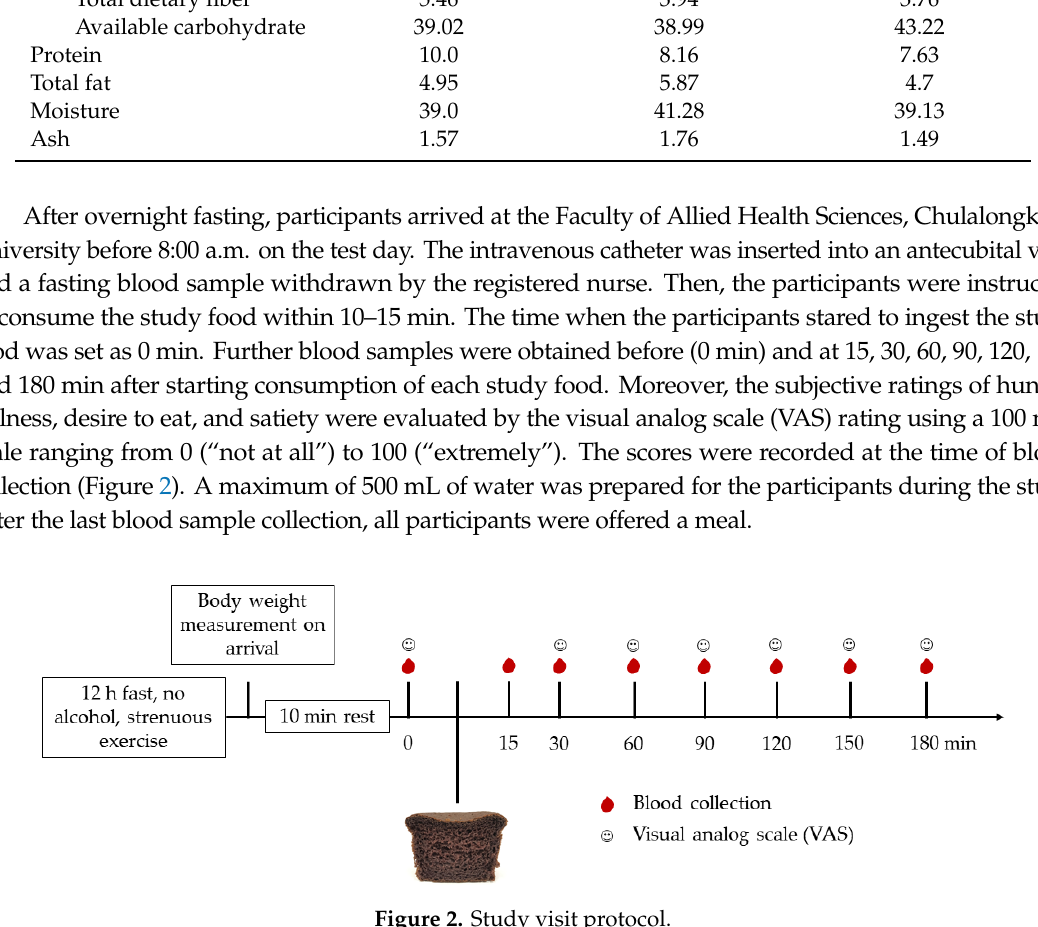
Table 1. Composition and nutritional contribution of the test breads.